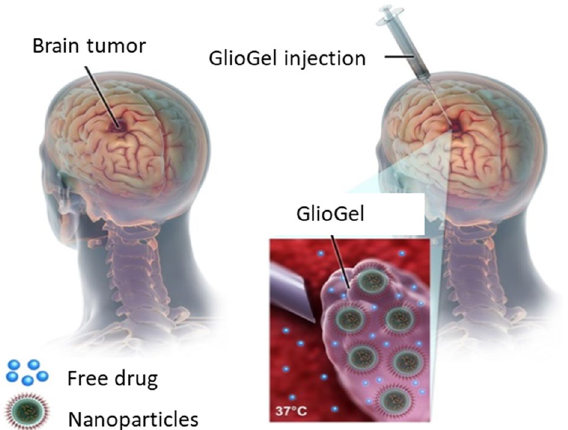
Figure 1. GlioGel formulation, composed of free temozolomide and stimuli-responsive paclitaxel-loaded MSN, can be injected in the tumour cavity after resection